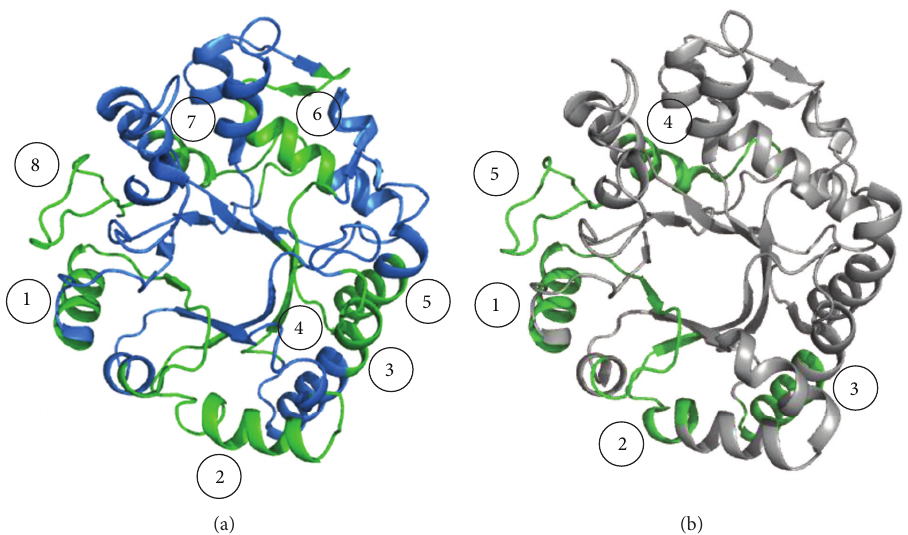
Figure 2: (a) Overall structure of Hev b 2 showing IgE binding epitopes (in green). (b) Overall structure of 𝛽 -1,3-glucanase from banana showing IgE binding epitopes (in green).